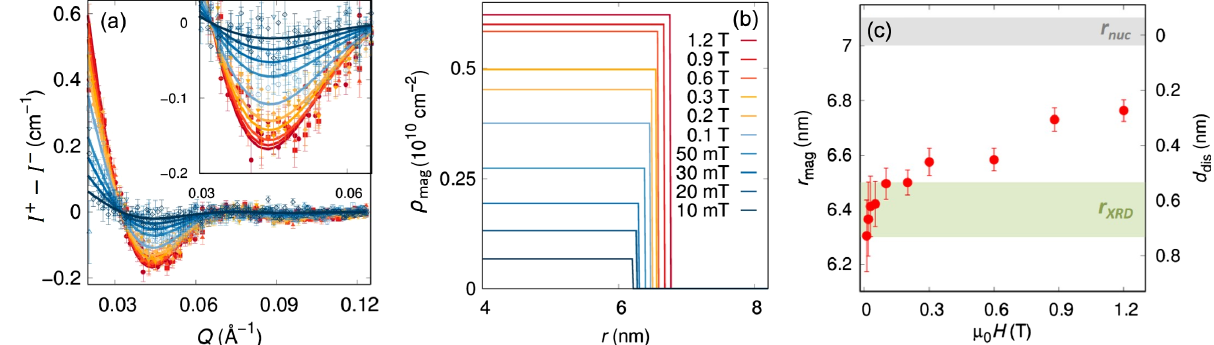
FIG. 3. (a) Nuclear-magnetic scattering interference term I þ − I − (points) at various applied magnetic fields [same color code as in (b)] and corresponding fits (lines). Inset: Enlarged region of Q ¼ 0 . 03 – 0 . 065 Å − 1 . (b) Field-dependent magnetic scattering length density ρ profiles. (c) Field dependence of the derived magnetic radius r and the disordered shell thickness d . The uncertainty mag mag dis intervals of nuclear ( r ) and structurally coherent radius ( r ) are indicated in gray and green, respectively. nuc XRD